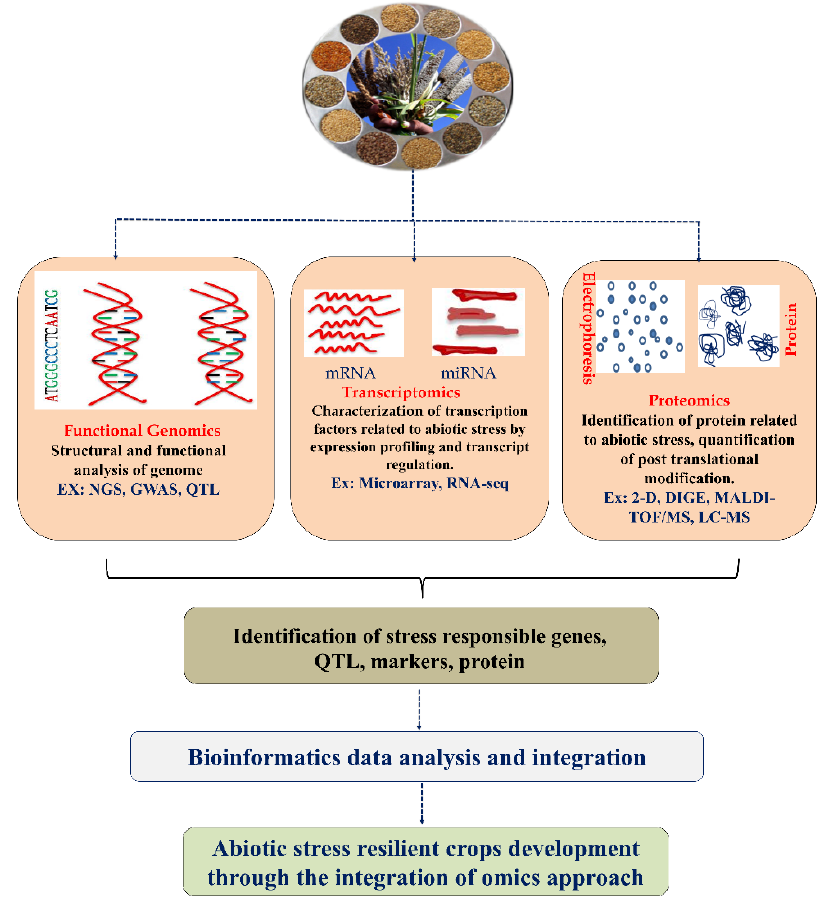
Figure 1. A schematic representation of omics approaches for identification of major regulator of stress response in the plant. QTL — quantitative trait locus; MAS — marker-assisted selection 2D gel electrophoresis; DIGE — differential gel electrophoresis; MALDI-TOF — matrix-assisted laser desorption/ionization time-of-flight; LC-MS/MS — liquid chromatography/mass spectrometry. Sources of the cereal image ( https://agritech.tnau.ac.in/agriculture/millets_miracle_strategies.html (accessed on 17 October 2022)).